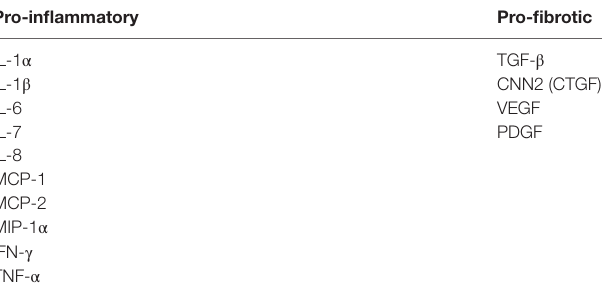
TABLE 2 | SASP factors associated with inflammation or